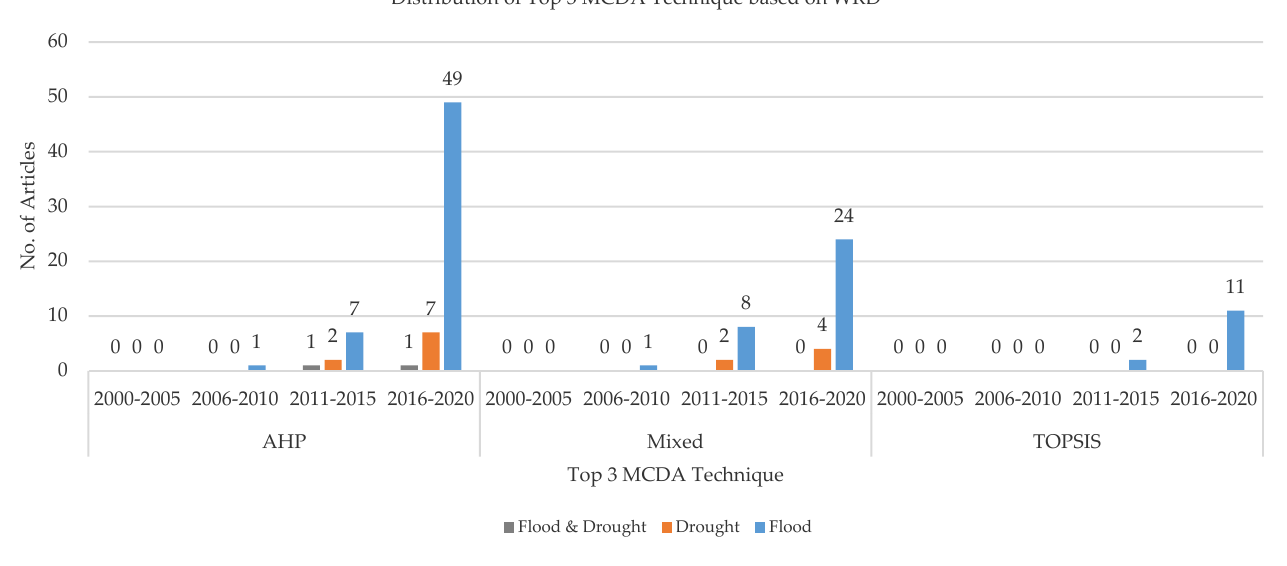
Table 8. Classification of MCDA techniques based on WRD events.